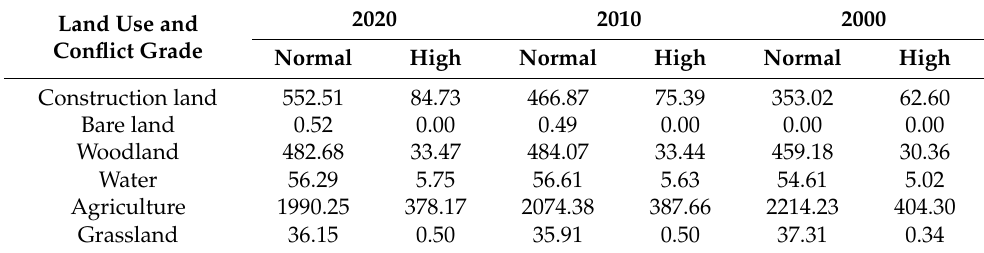
Table 3. Land-use status of conflict unit (km 2 ).